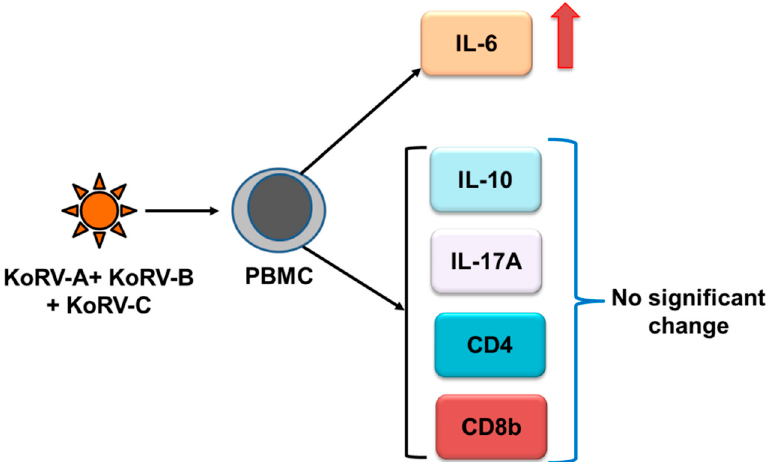
Figure 2. Cytokine, CD4, and CD8b responses to multiple KoRV subtype infections in koala PBMCs (summarized from [84]), which were compared to KoRV-A–only infected koalas.